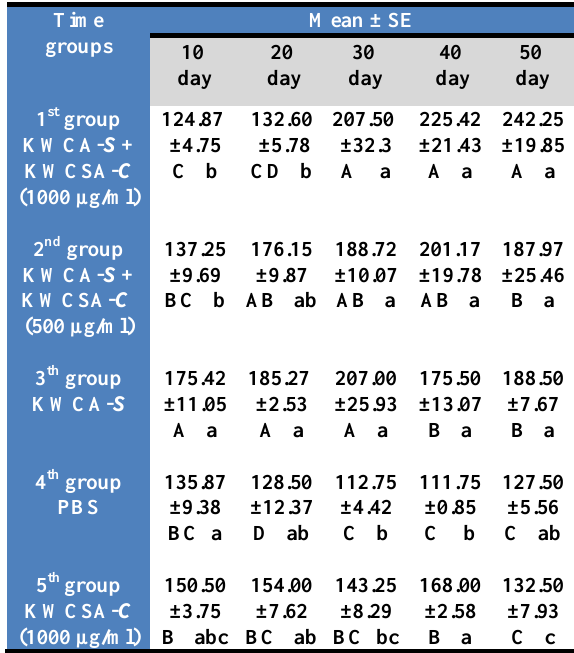
Table, 2: IL-6 concentration (pg) in white rats immunized by killed whole cell Salmonella enterica subspecies typhimurium and sonicated whole cell Cryptococcus neoformans antigens.